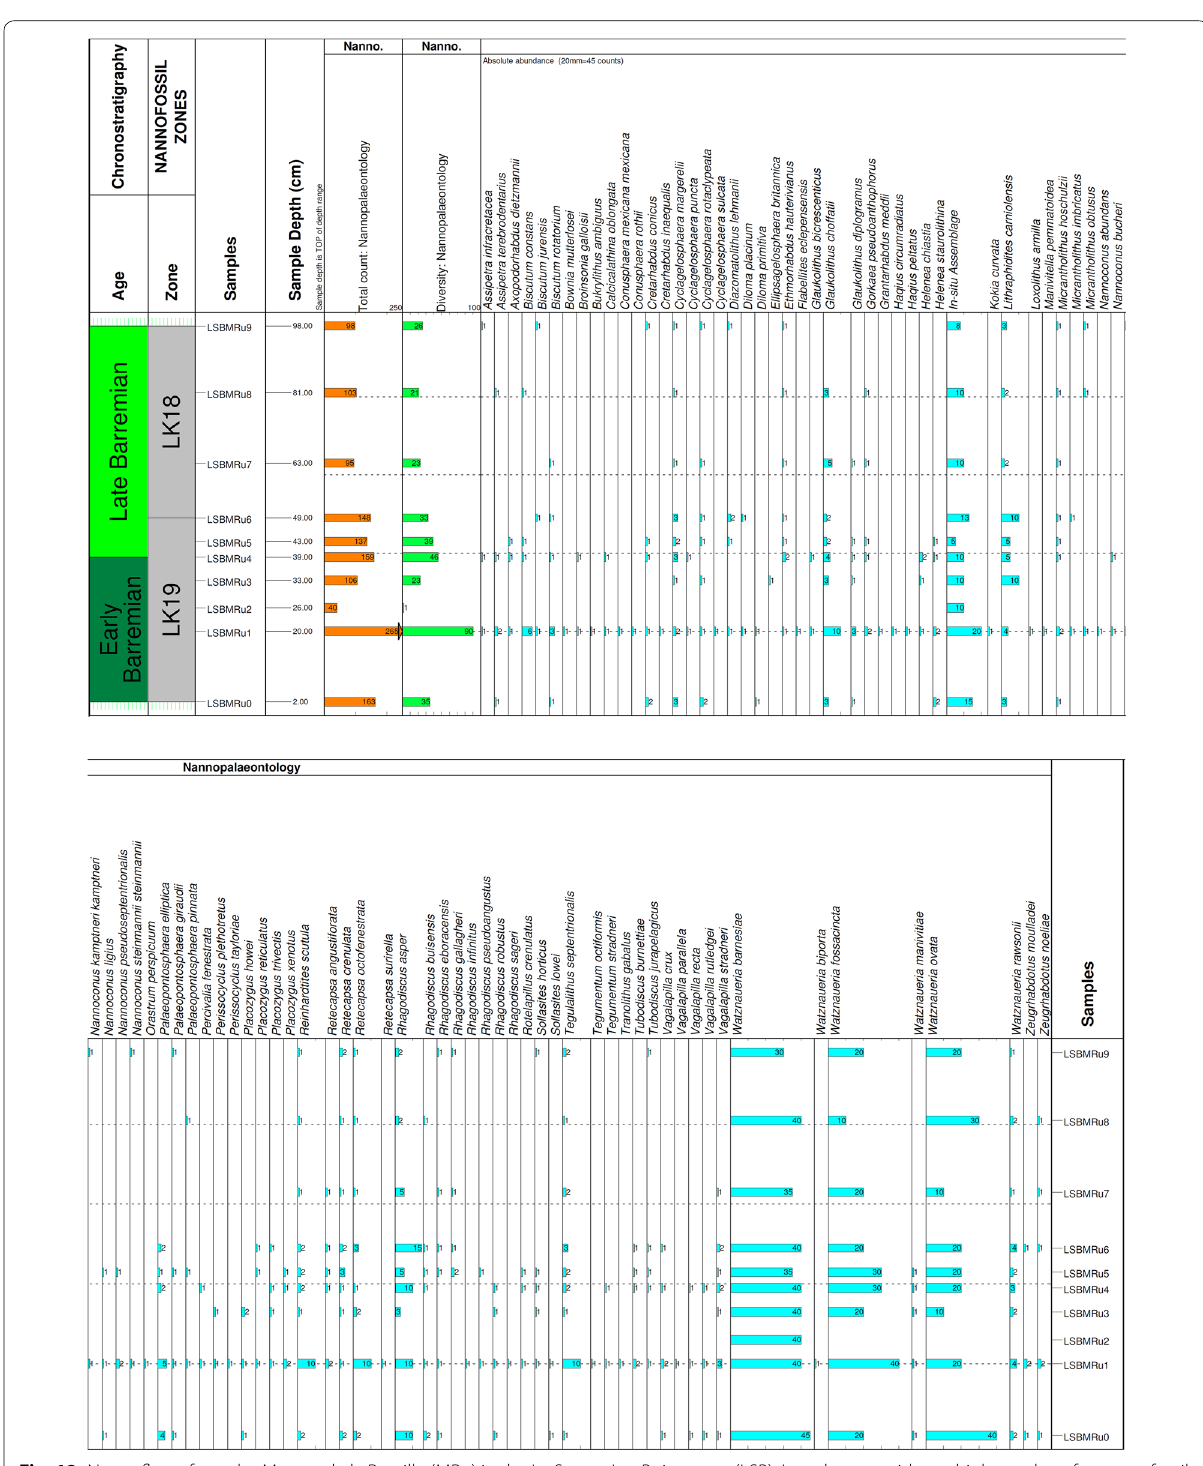
Fig. 12 Nannofloras from the Marnes de la Russille (MRu) in the La Sarraz–Les Buis quarry (LSB). In order to avoid very high numbers for nannofossil counts, a 0–100 based counting system is used. The numbers for individual species represent semi‑quantitative count estimation of specimens/100 fields of view (FOV). Numbers from 1 to 20 represent the estimation of species per 100 FOV. Numbers above 20 are coded: 25 (one specimen/4FOV), 30 (one specimen/3FOV), 35 (one specimen/2FOV), 40 (one specimen/1FOV), 45 (two specimens/1FOV). The numbers for total abundance (in situ) estimation represent the number of specimens per 5